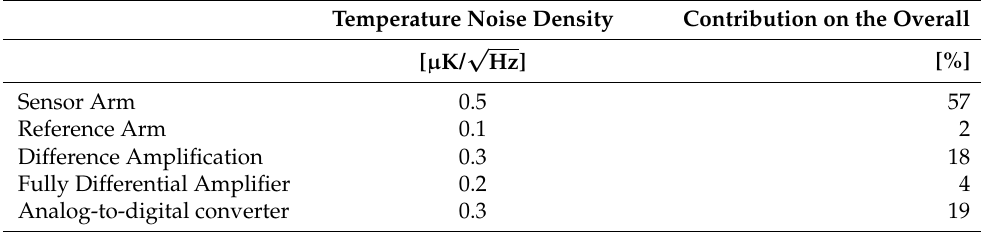
Figure 5. Theoretical noise in the full sensing range; the black solid line is the voltage noise, and the dashed blue line is the same noise converted to temperature by means of the expected sensitivity. Table 1. Summary of the read-out noise